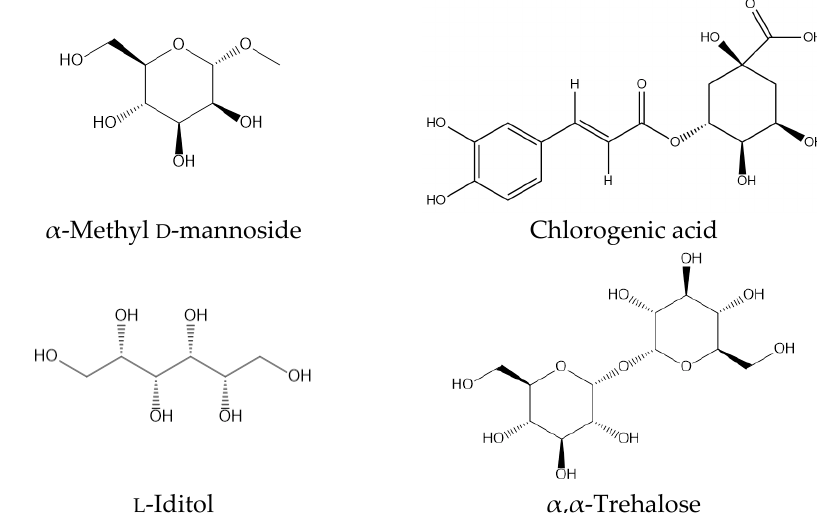
Figure 6. The chemical structures of ten main compounds identified in EAF from Pingguoli pear fermentation broth.